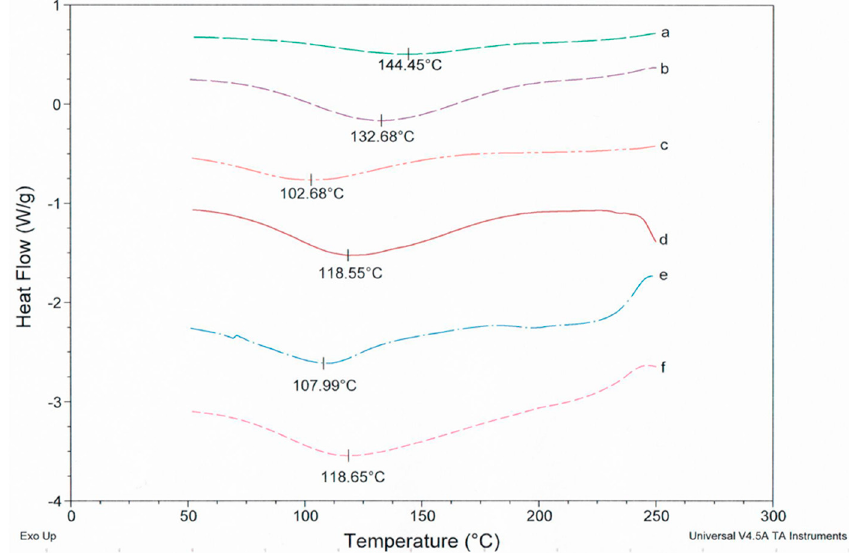
Figure 7. DSC scanning results of ( a ) pullulan powders; ( b ) electrospun pullulan fibers without salts; ( c ) with 2.0 M NaCl; ( d ) with 0.1 M NaCl; ( e ) 0.5 M Na 3 C 6 H 5 O 7 ; and ( f ) 0.1 M Na 3 C 6 H 5 O 7 .